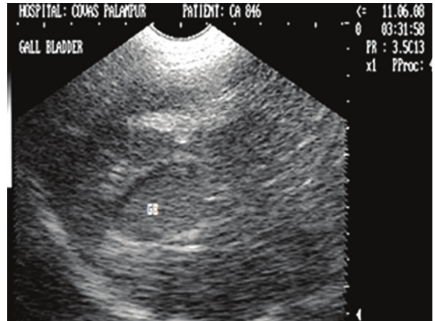
Figure 22: Transverse sonogram (2D) of right medial liver lobe of two and half-year-old intact female Pointer dog depicting generalized hyperechoic parenchyma with biliary sludge in gall bladder.